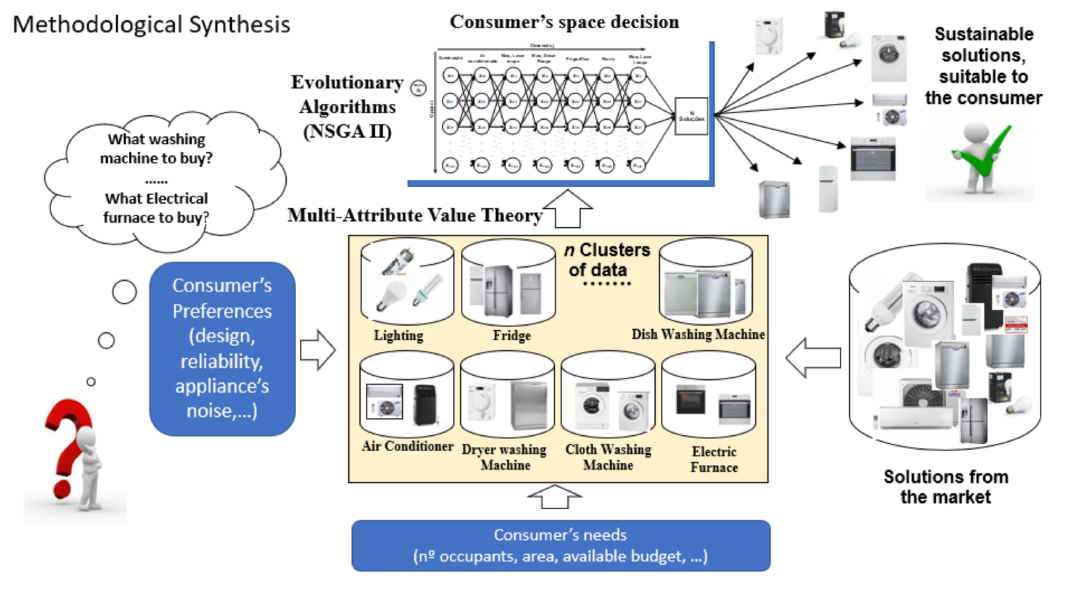
Figure 1. Proposed